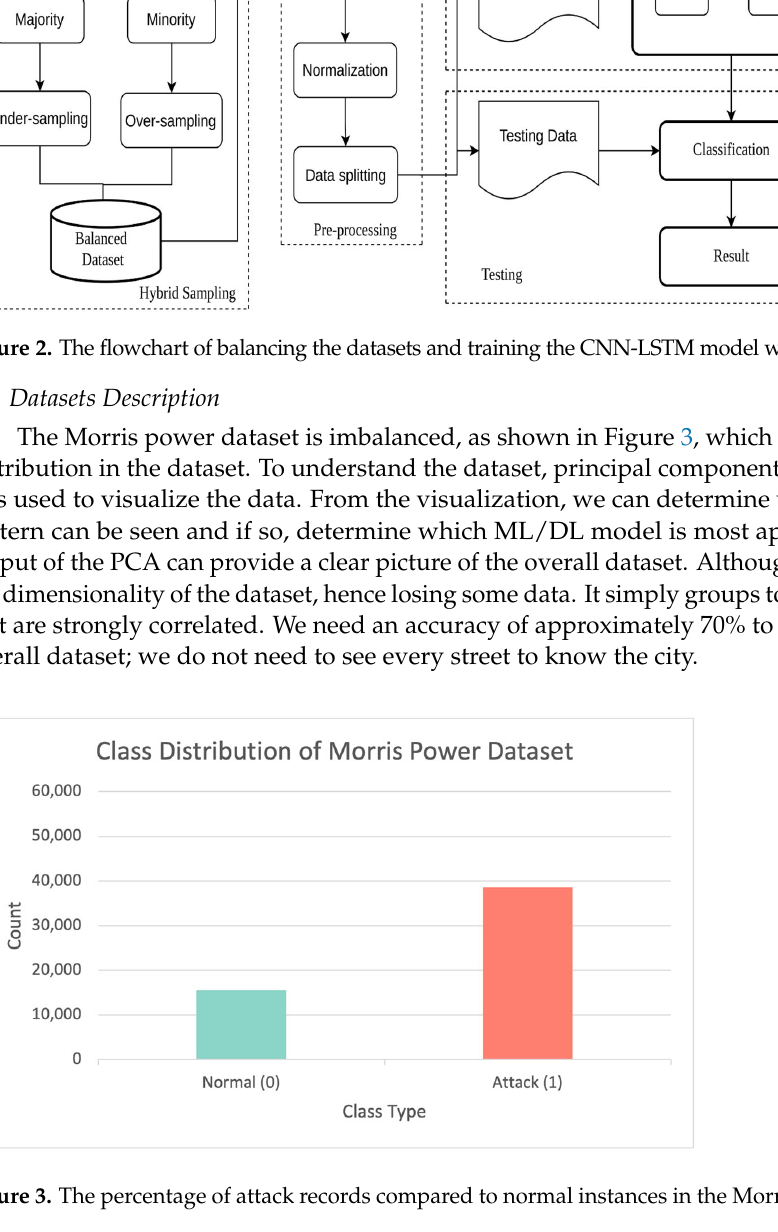
Figure 4. The result of conducting principal component analysis (PCA) on the Morris power Dda ‐ taset. The Canadian Cyber Security Institute collected and assembled the CICIDS2017 da ‐ taset with the help of the B ‐ Profile system at the end of 2017 [16]. The dataset contains 2,830,473 network traffic samples, with benign traffic accounting for 80.30 percent and attack traffic accounting for 19.70 percent. The categories include the most prevalent at ‐ tacks, such as DoS, DDoS, Botnet, PortScan, web attacks, etc. The dataset collects 84 fea ‐ tures from the generated network traffic, with the multiclass label being the last column. Furthermore, compared to publicly available datasets from 1998 to 2016, this dataset en ‐ tirely fits the 11 performance evaluation criteria. The CICIDS2017 dataset is divided sim ‐ ilarly to the UNSW ‐ NB15 dataset. Figure 5 depicts the CICIDS2017 data distribution for each class.